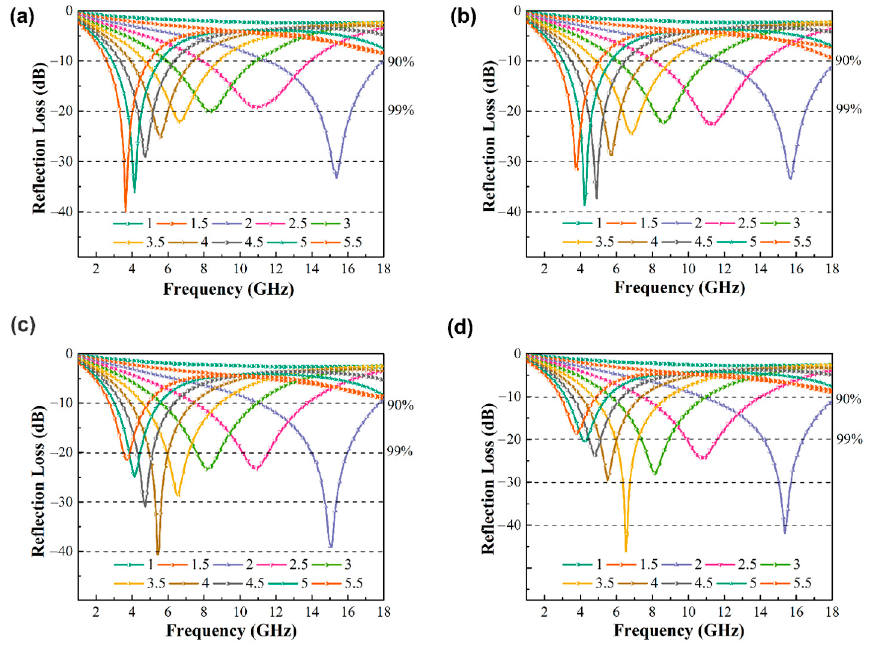
Figure 9. Reflection loss of Fe 73.2 Si 16.2 B 6.6 Nb 3 Cu 1 nanocrystalline alloy powder after milling for ( a ) 6 h, ( b ) 8 h, ( c ) 10 h, and ( d )12 h in the frequency range of 2–18 GHz.